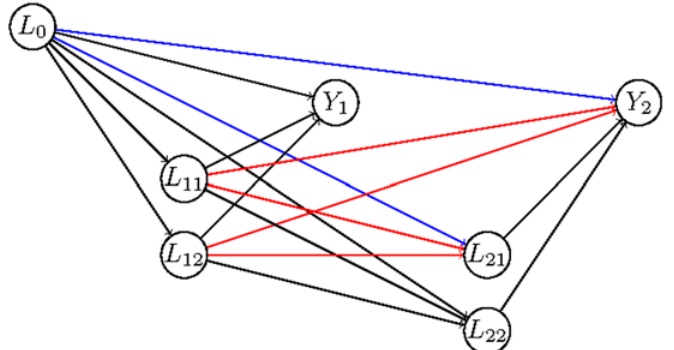
Fig 1. Directed acyclic graph, the arrows in blue and red denote the relations that confound the causal effect of L 21 on Y 2